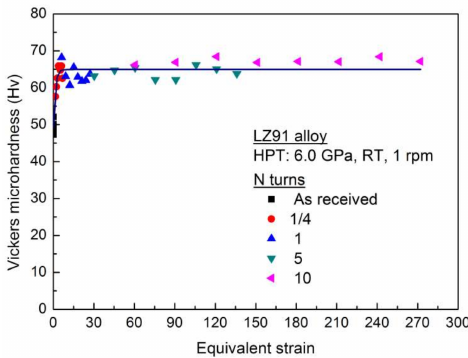
Figure 12. Relationship between Vickers microhardness and equivalent strain for LZ91 alloy before and after HPT processing with various numbers of torsion